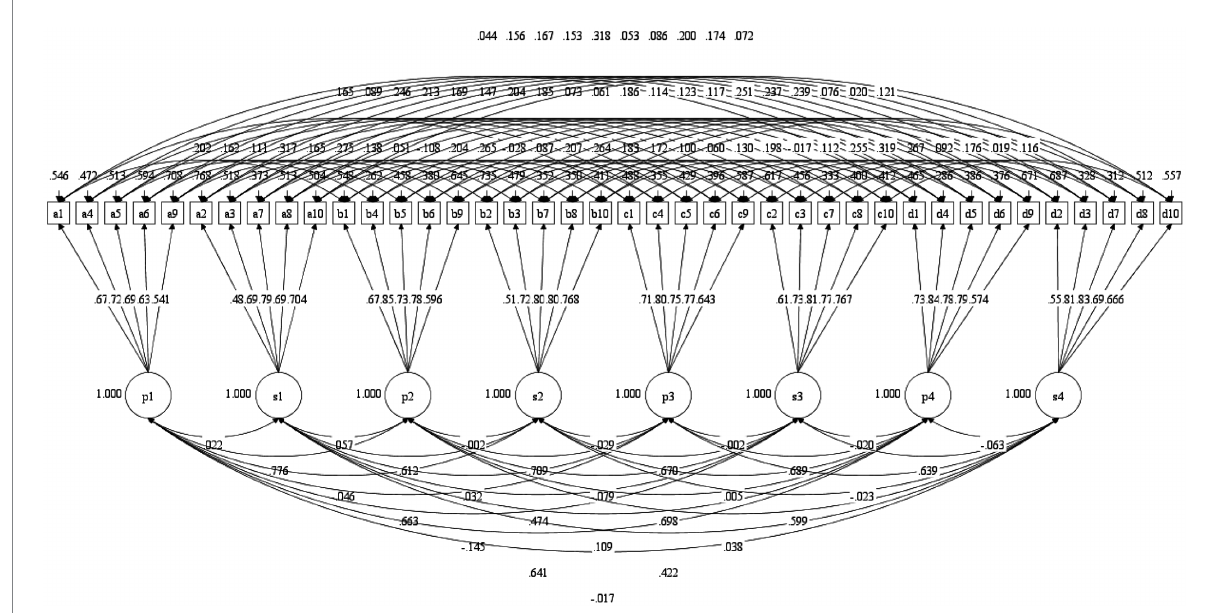
FIGURE 1 Diagram for the longitudinal configural invariance model. P1, presence of MLQ at Time 1; S1, search of MLQ at Time 1; P2, presence of MLQ at Time 2; S2, search of MLQ at Time 2; P3, presence of MLQ at Time 3; S3, search of MLQ at Time 3; P4, presence of MLQ at Time 4; S4, search of MLQ at Time 4.